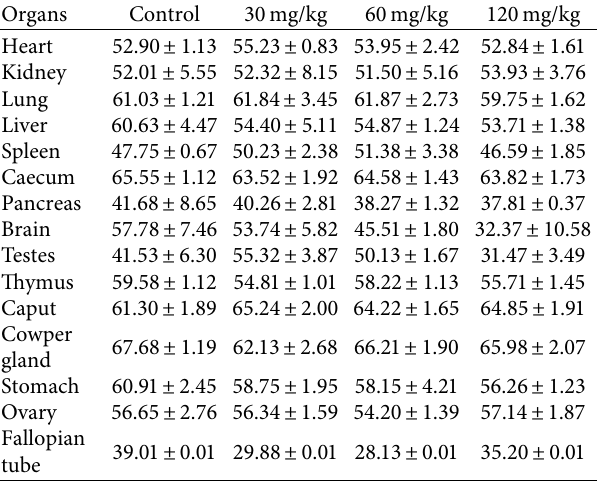
Table 2: The effects of goose bone on the percentage of water content of different